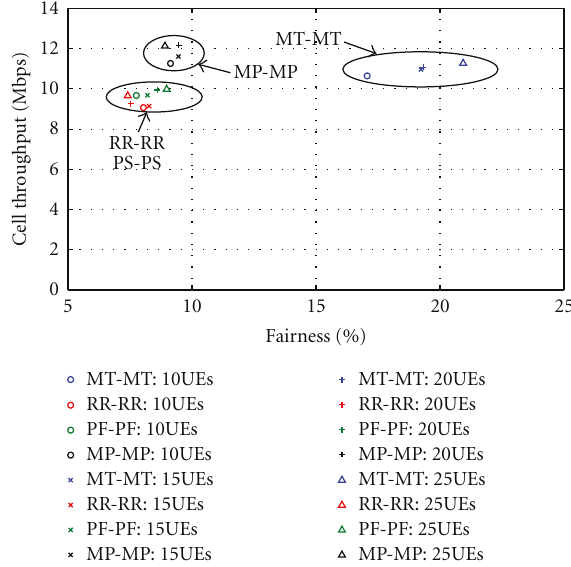
Figure 7: Fairness and cell